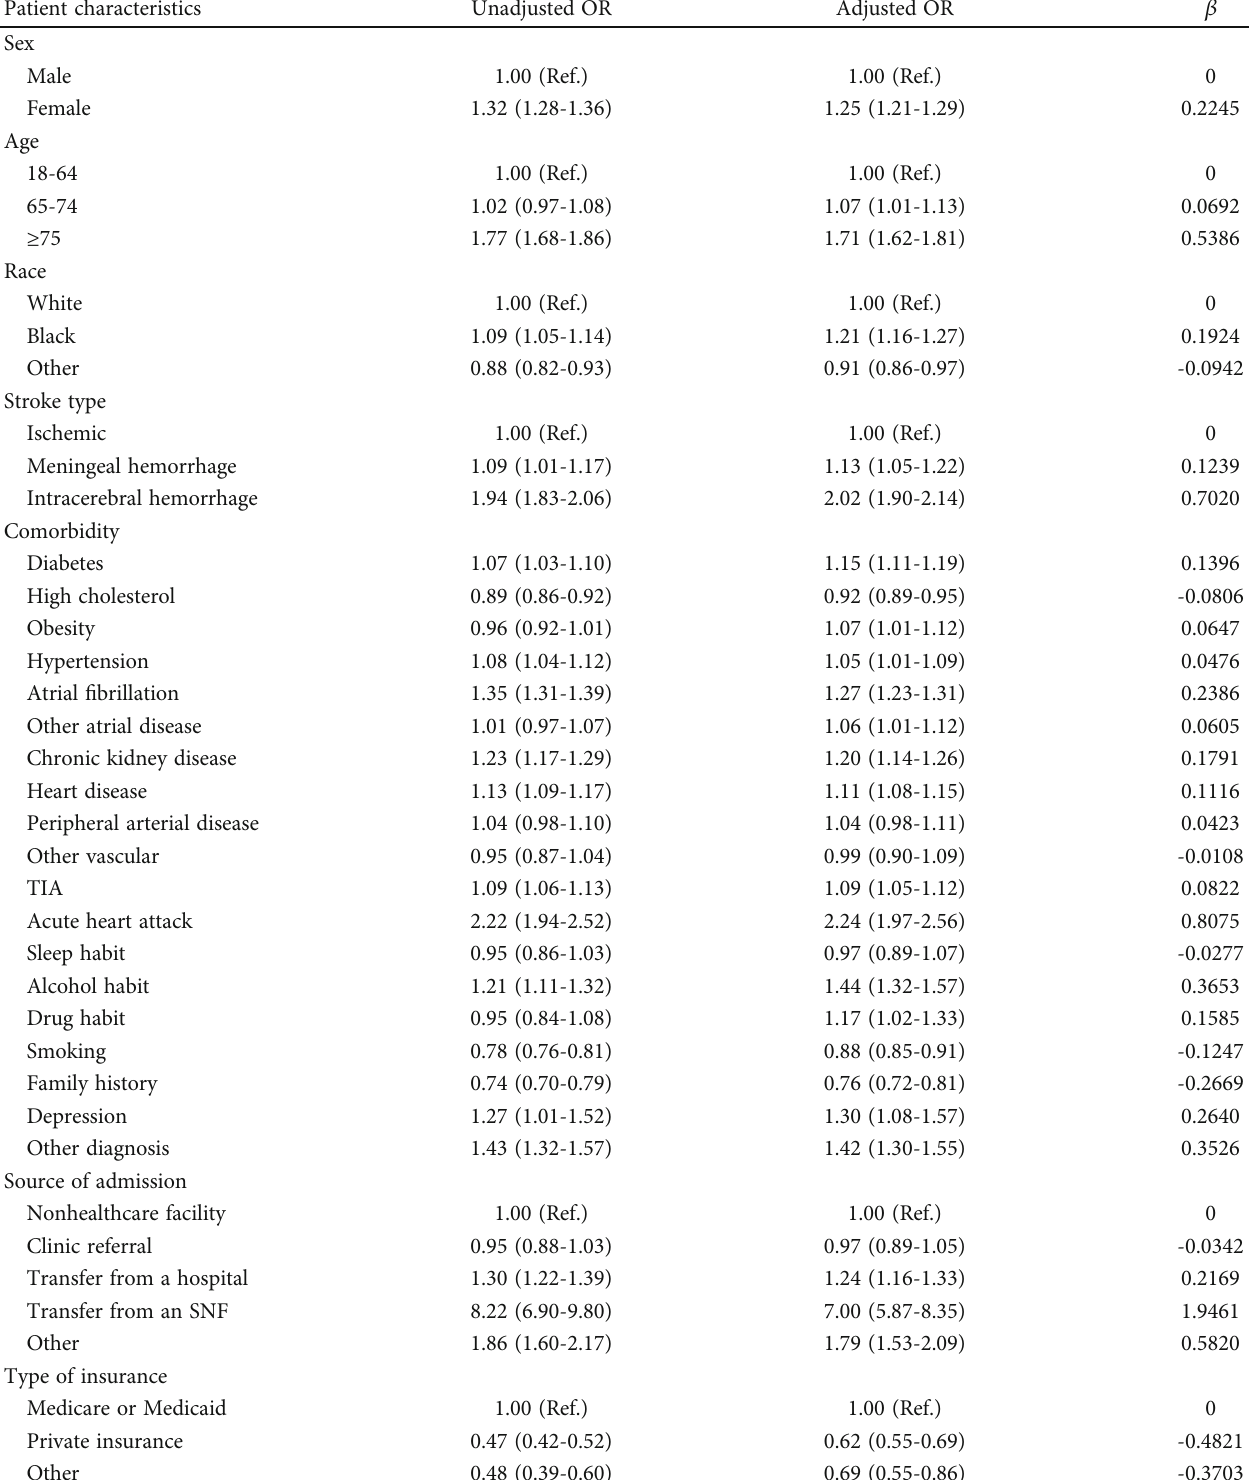
Table 4: Odds ratios of patient characteristics associated with facility